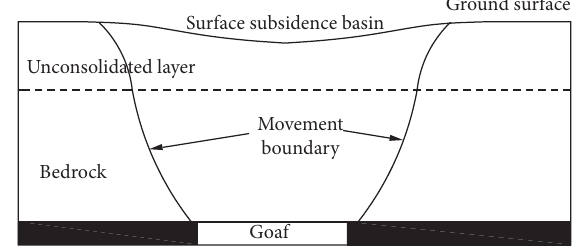
Figure 8: Movement boundary shape of overburden